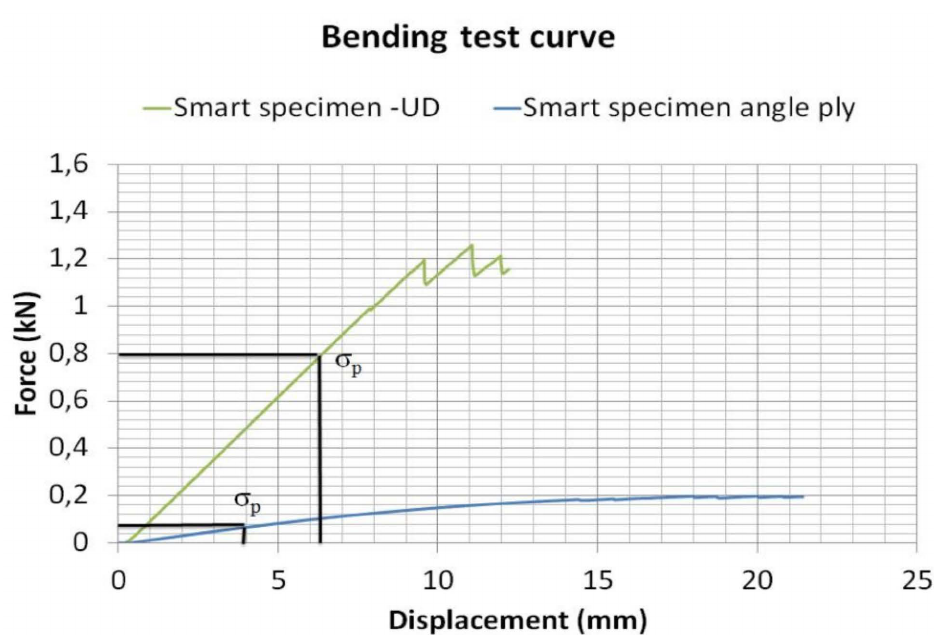
Figure 9. Quasi-static experiment result for CFRP specimen under 3-point bending.